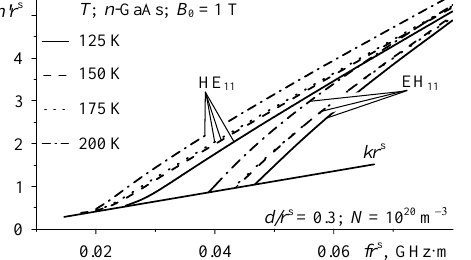
0.02 Fig. 9. Wave phase characteristics of models of gyroelectric n -GaAs semiconductor-dielectric waveguides, when d/r s = 0.3; B 0 = 1 T; N =10 20 m –3 .